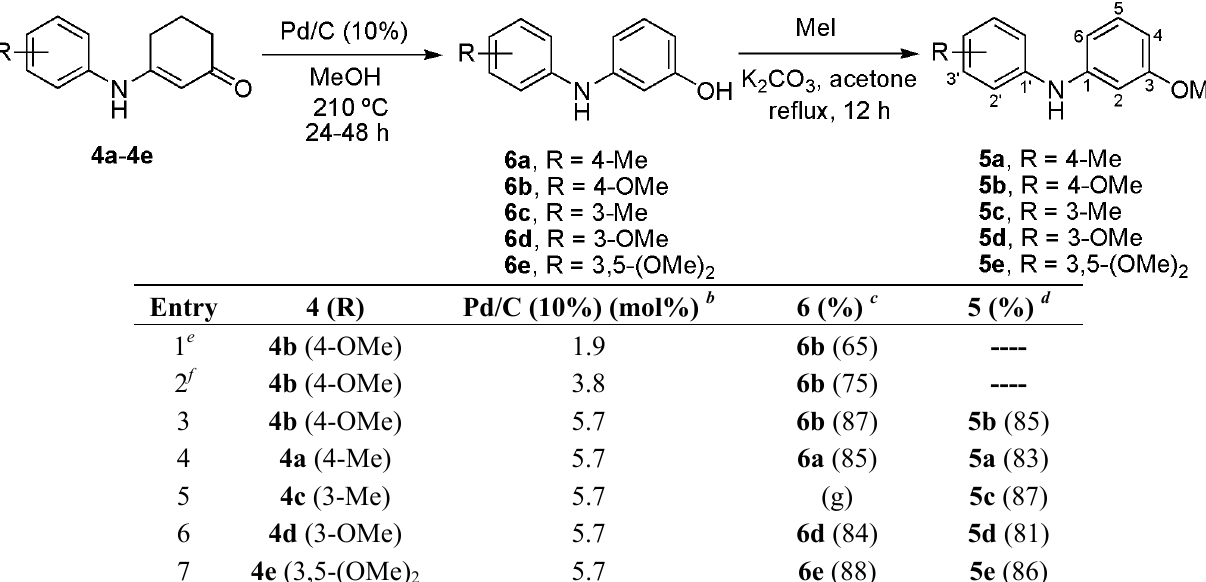
Entry 4 (R) Pd/C (10%) (mol%)